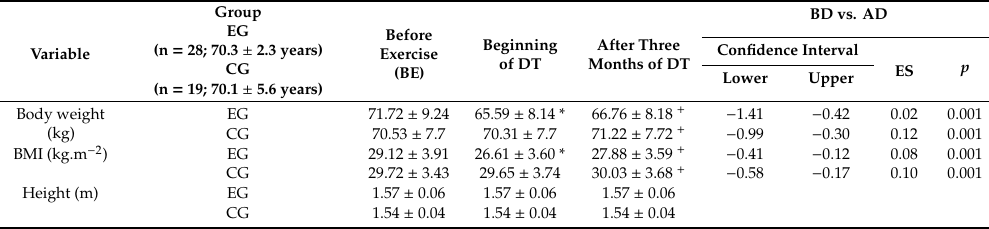
Table 1. Subject’s anthropometric